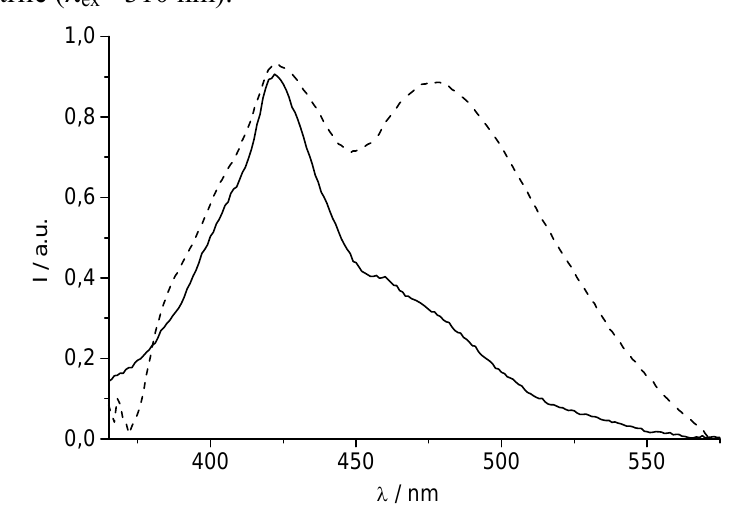
Figure 6. Comparison the emission spectra of TpyTol in ethanol ( ___ ) and TpyPhPyrene (---) in acetonitrile (  = 310 ex